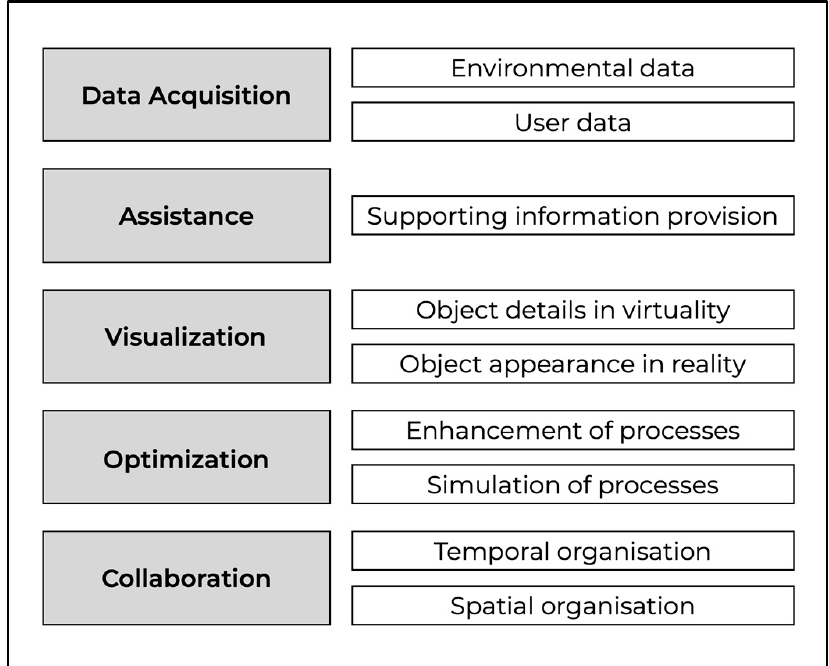
Figure 3. Summary of dimensions and characteristics of the XR deployment purposes .